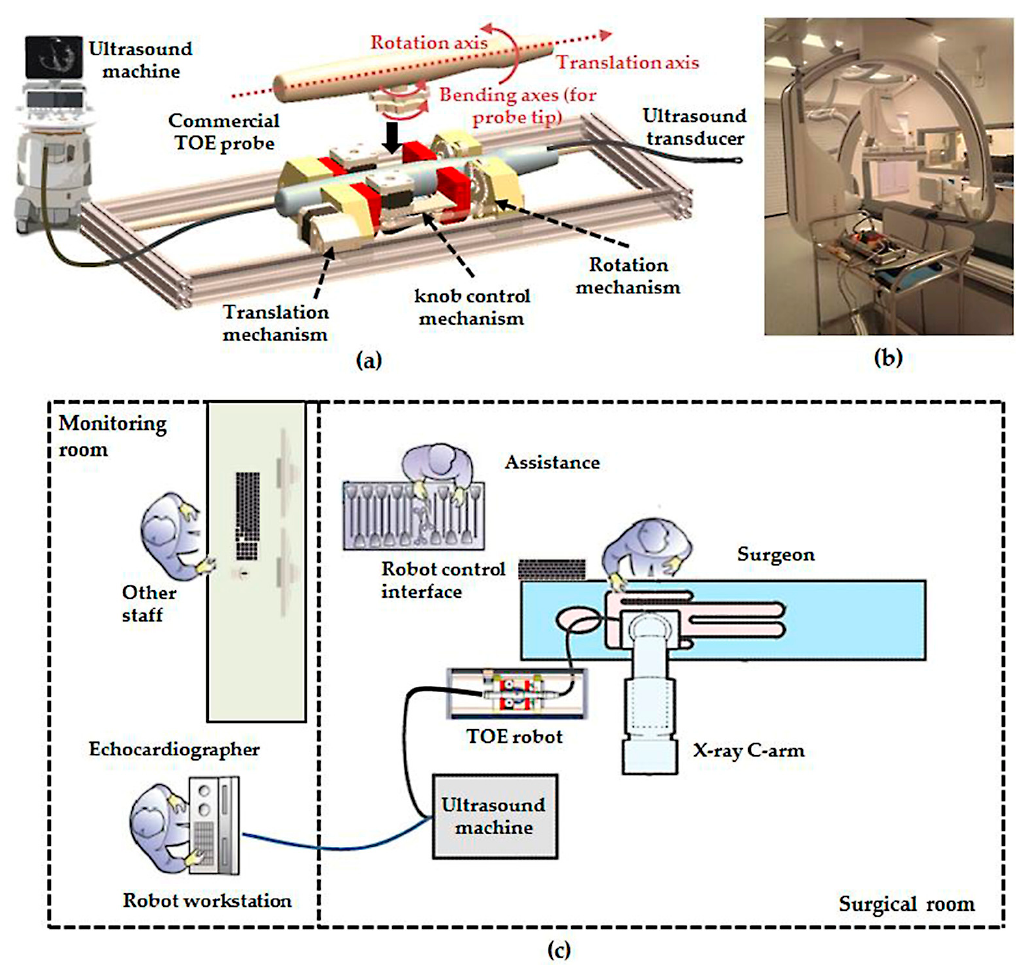
Figure 1. ( a ) Schematic drawing of the proposed add-on robotic trans-oesophageal echocardiography (TOE) system; ( b ) Photo of the implemented system in the surgical room with a trolley; ( c ) Floor plan of the potential use of the robotic TOE system in the surgical and monitoring rooms for cardiac procedures.